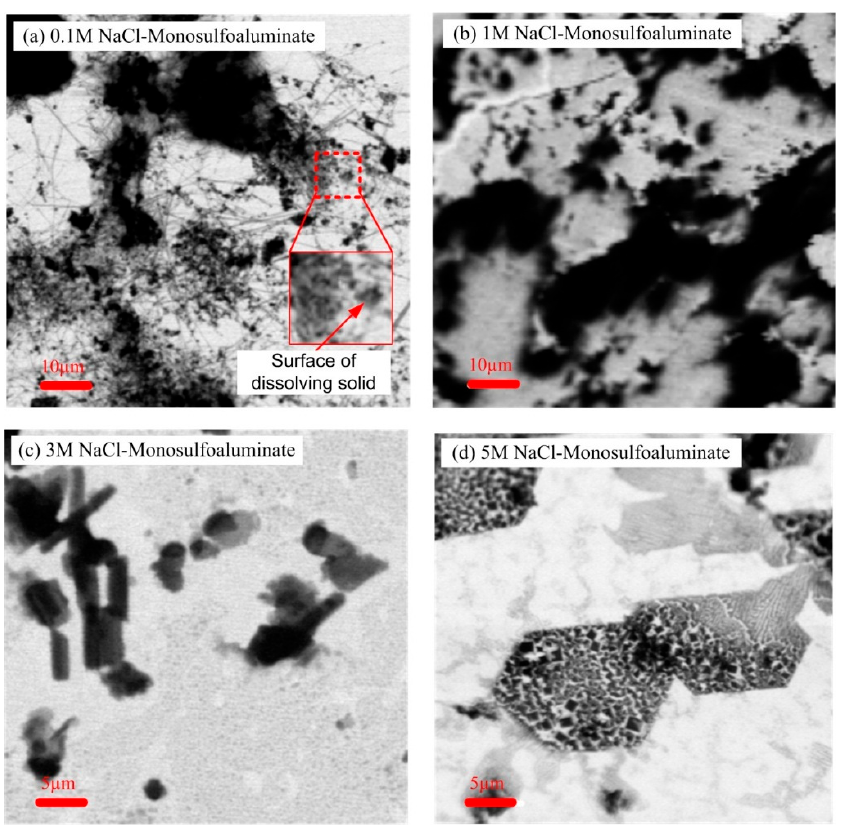
Figure 5. STXM images of NaCl-reacted monosulfoaluminate samples in: ( a ) 0.1 M; ( b ) 1 M; ( c ) 3 M; and ( d ) 5 M NaCl solutions.